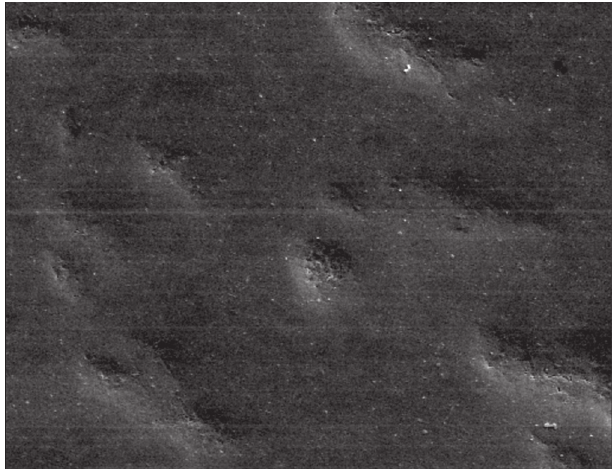
Figure 1. SEM of CP Ti polished surface before incubation in Mueller Hinton Broth.